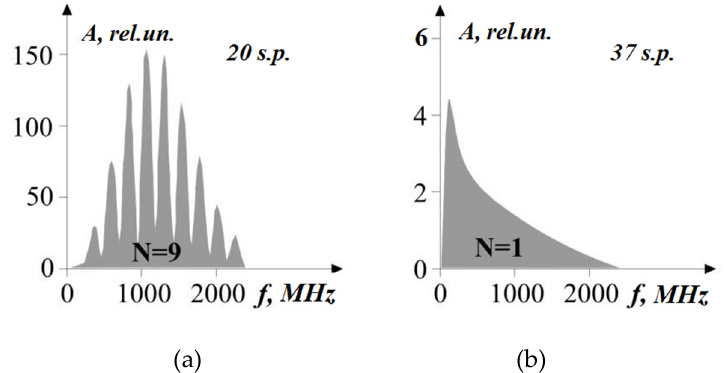
Figure 6. Fourier spectra of the GPR traces of a radargram (Figure 5b) ( a ) with massive ice; ( b ) without massive ice.